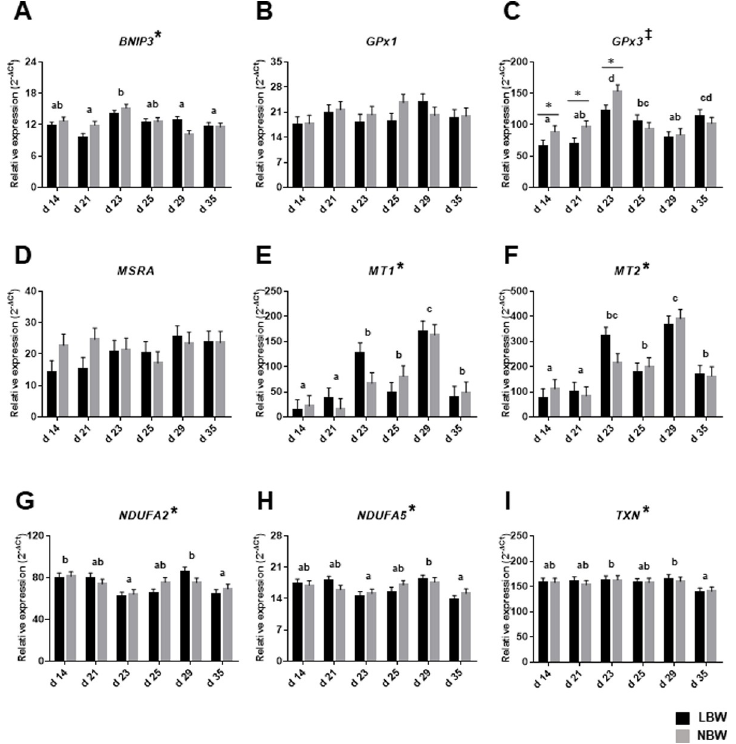
Fig 3. Relative mRNA levels of BNIP3 , GPx1 , GPx3 , MRSA , MT1 , MT2 , NDUFA2 , NDUFA5 and TXN were analyzed in kidney of LBW and NBW piglets of different ages throughout the peri-weaning period. Bars in the graphs represent least-square means ± SEM of 10 piglets. Asterisk ( � ) indicates a significant effect of the age on means at P � 0.05. Dagger (†) indicates a significant effect of the birth weight on means at P � 0.05. Pound (#) indicates that means tended to be affected by birth weight at P < 0.10. Double cross(‡) indicates a significant interaction between age and birth weight at P < 0.01. Detailed P-Values for main effects and interactions are available in S15 Table in S1 File comparative analysis with litter and gender as random cofactors in S16 Table in S1 File and box plot of raw data distribution in S4 Fig in S1 File. Ages with different letters (a, b, c, d) within the graphs are statistically different at P � 0.05.LBW = low-birth weight piglets; NBW = normal-birth weight piglets; (A) BNIP3 = BCL2 interacting protein 3; (B) GPx1 = glutathione peroxidase 1; (C) GPx3 = glutathione peroxidase 3; (D) MRSA = methionine sulfoxide reductase A; (E) MT1 = metallothionein 1A; (F) MT2 = metallothionein 2B; (G) NDUFA2 = NADH ubiquinone oxidoreductase subunit A2; (H) NDUFA5 = NADH ubiquinone oxidoreductase subunit A5; (I) TXN =